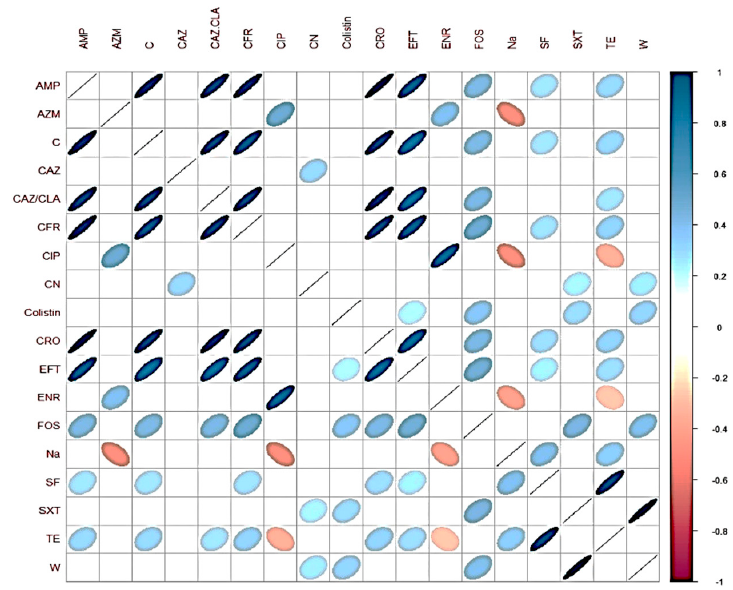
Figure 2. Spearman test correspondence map for phenotypic susceptibility antibiotic in strains of S. Infantis.